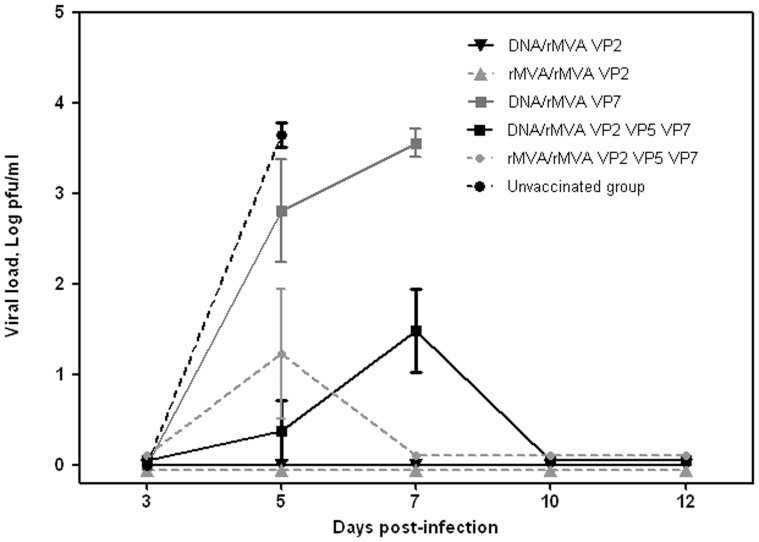
Viral load (log pfu/ml) of blood samples collected from vaccinated and control mice after challenge with BTV-8.Virus was extracted from blood of immunized and non-immunized mice after challenge and determined as described in Materials and Methods. Each point represents the mean values of the viral titer of six animals and standard errors are shown as bars.